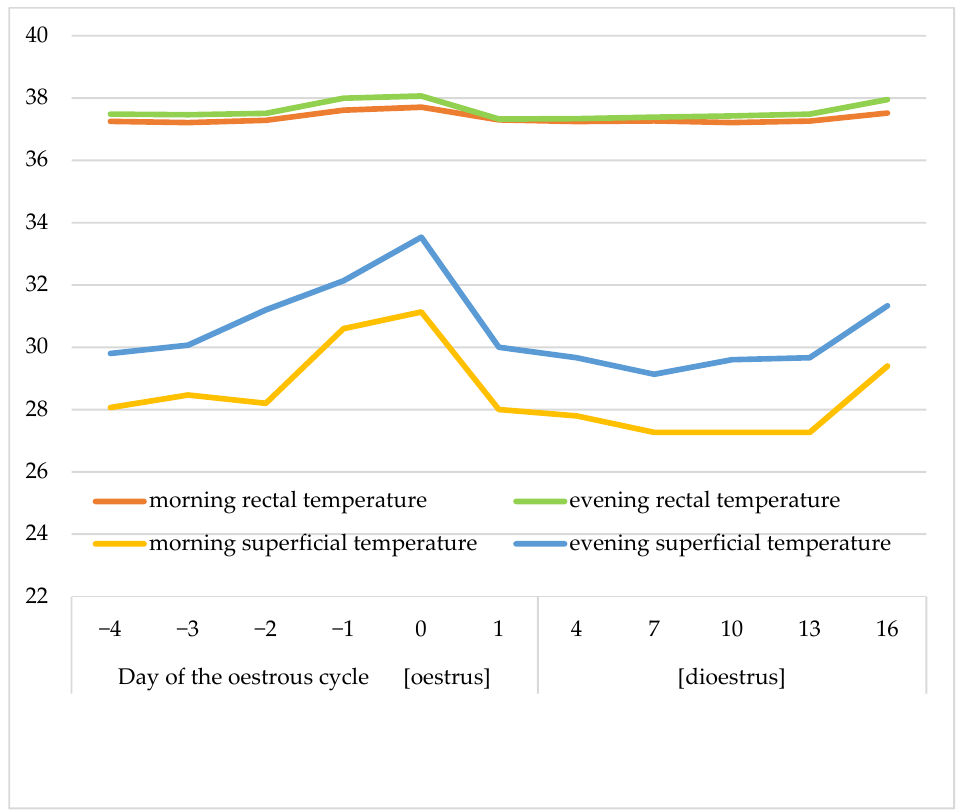
Figure 3. Dynamics of changes in mean rectal and superficial temperatures (°C) in the morning and evening during the oestrous cycle.